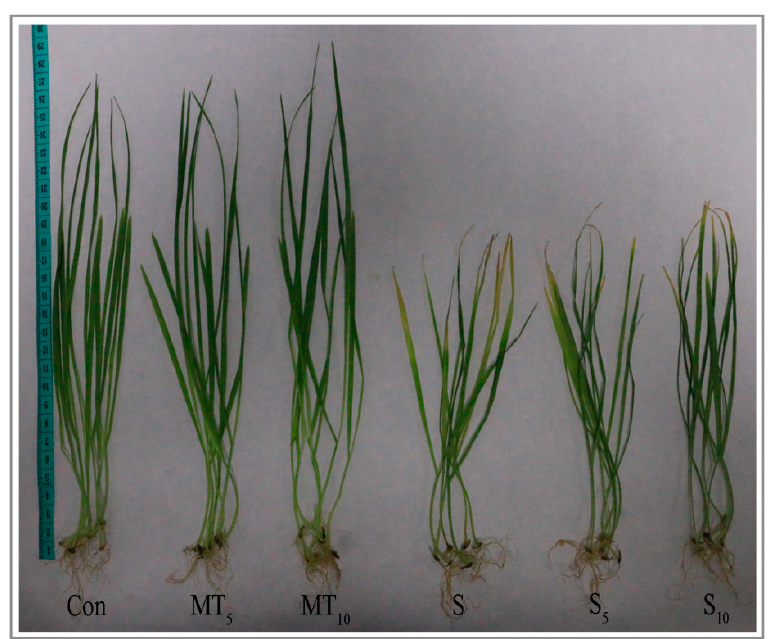
Figure 2. The performance of plant seedlings under normal and salt stress conditions. Photographs were taken after six days of the salt plus melatonin (MT) pretreatment.